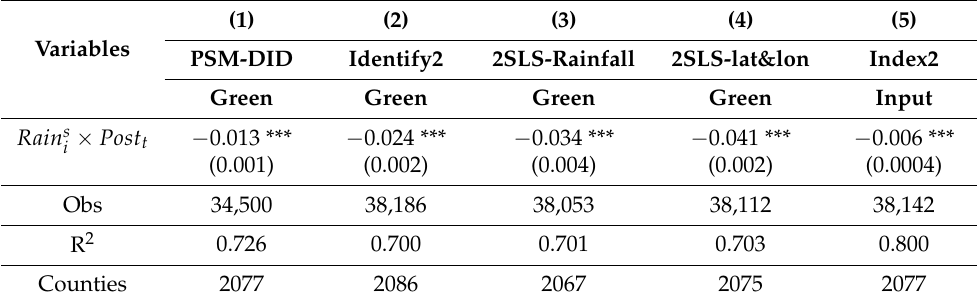
Table 6. Considering different indicators and